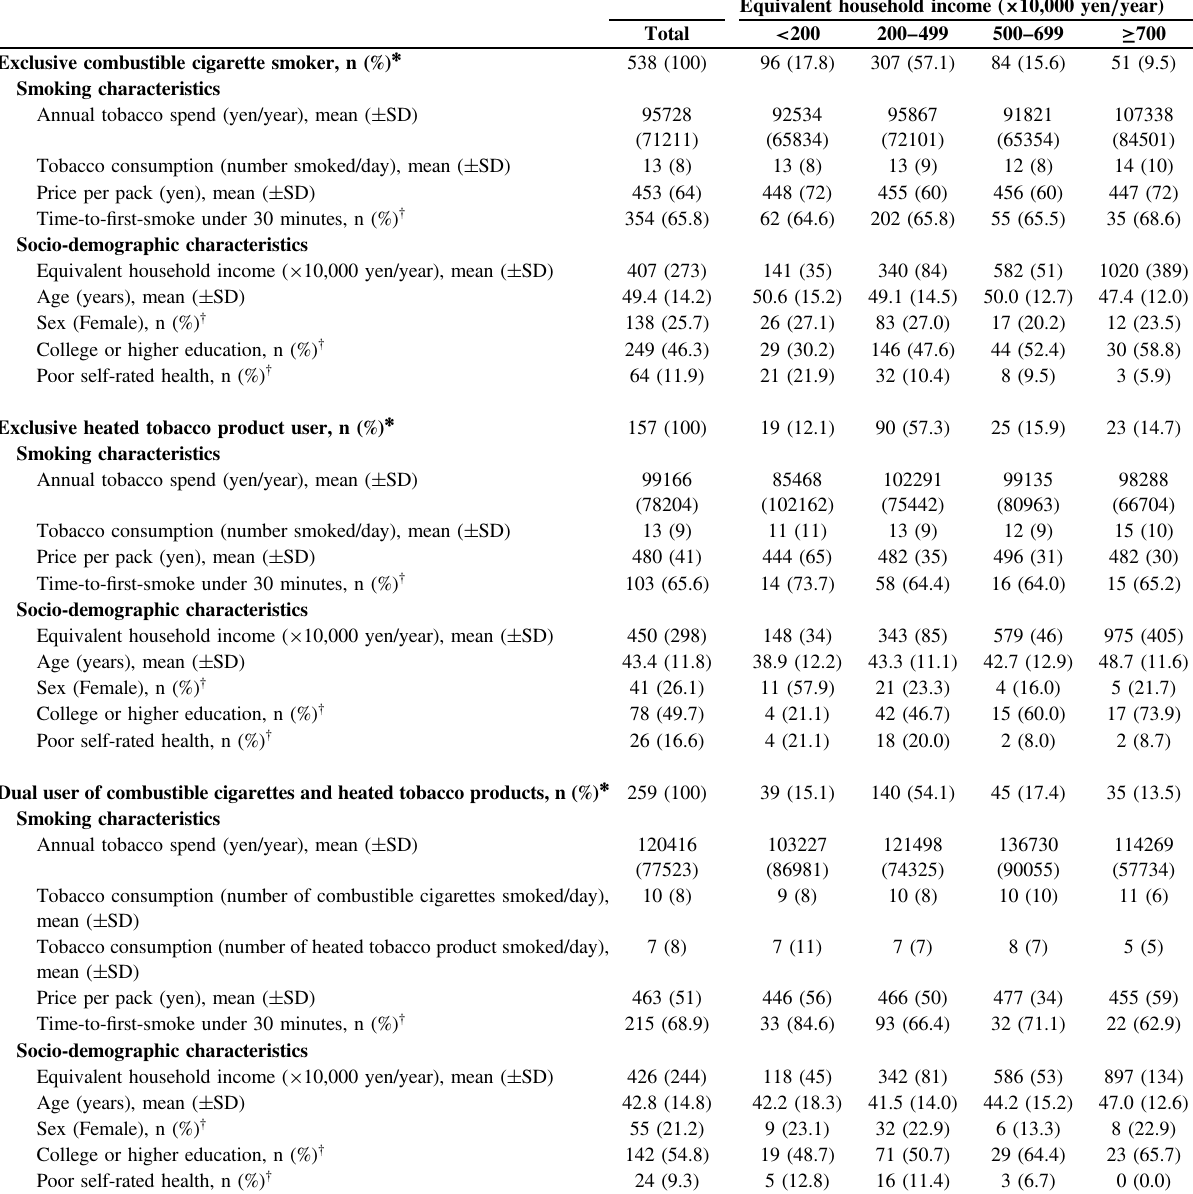
Table 1 Characteristics of tobacco product smokers according to equivalent household